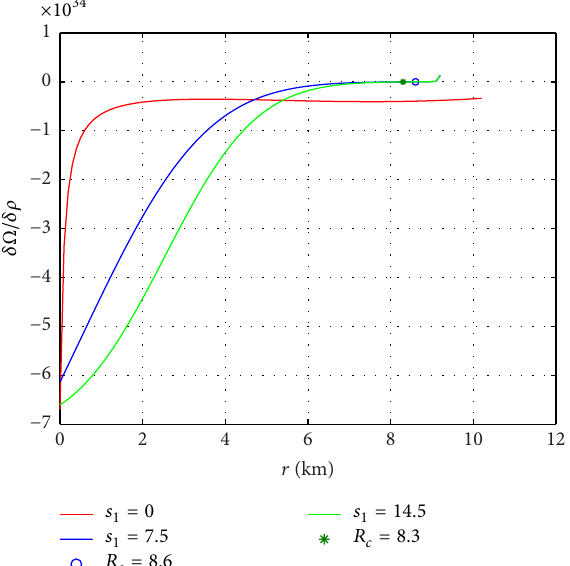
Figure 5: Cracking of PSR J1614-2230 with 𝛾 = 0.163 , 𝛼 = 0.21 , and = 0, 7.5, 14.5 𝑠 1